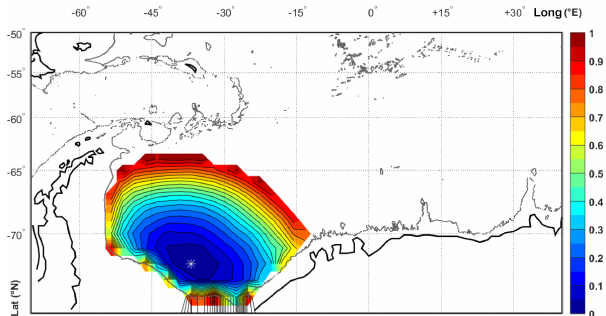
Figure 10. The e-folding decay scale for a grid point at ∼ 38 ◦ E, 72 ◦ S. The grey contour shows the 2000m